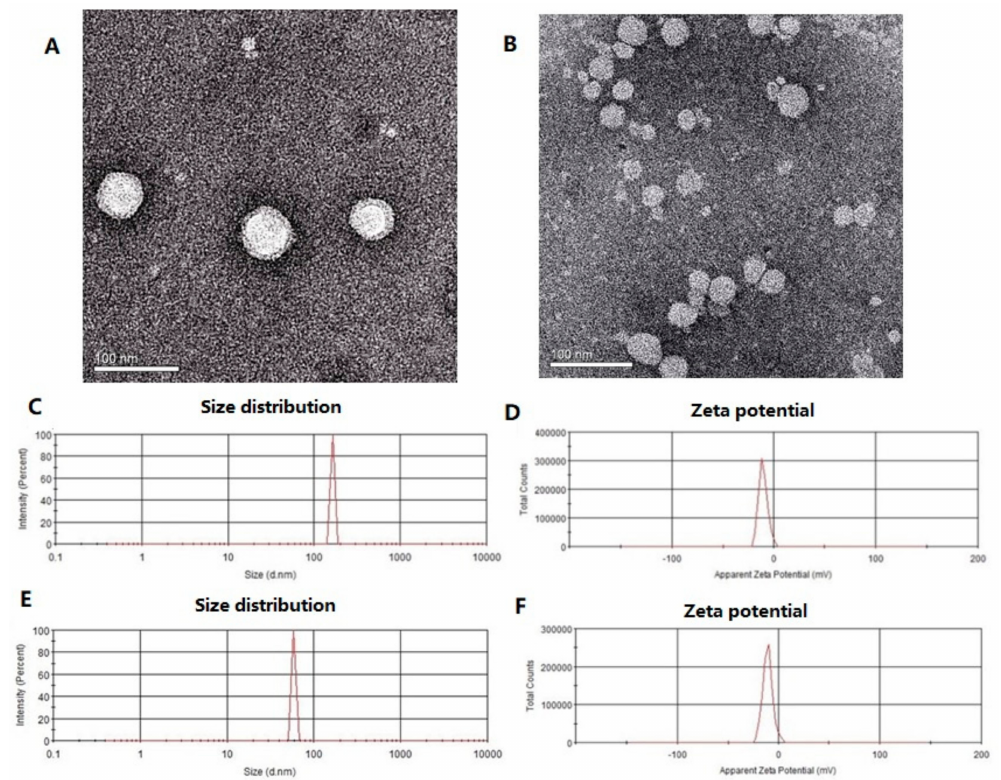
Figure 1. Morphology of RSV-SLNs and SLNs observed by TEM ( A , B ); The size distribution and zeta potential for RSV-SLNs ( C , D ); The size distribution and zeta potential for SLNs ( E , F ). RSV-SLNs: resveratrol-loaded solid lipid nanoparticles; SLNs: solid lipid nanoparticles; TEM: transmission electron microscopy.